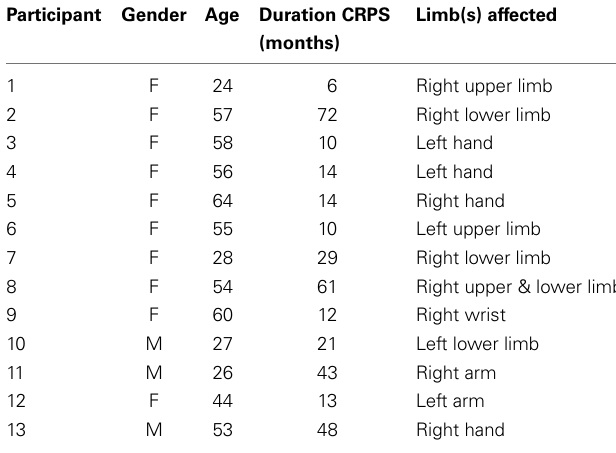
Table 1 | Characteristics of